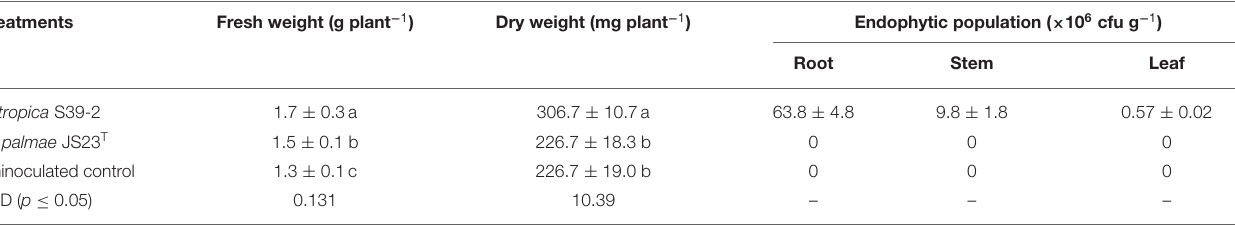
TABLE 4 | Endophytic population of Burkholderia related strains in various tissues of Jatropha at 60 DAI under sterile N-limiting conditions.